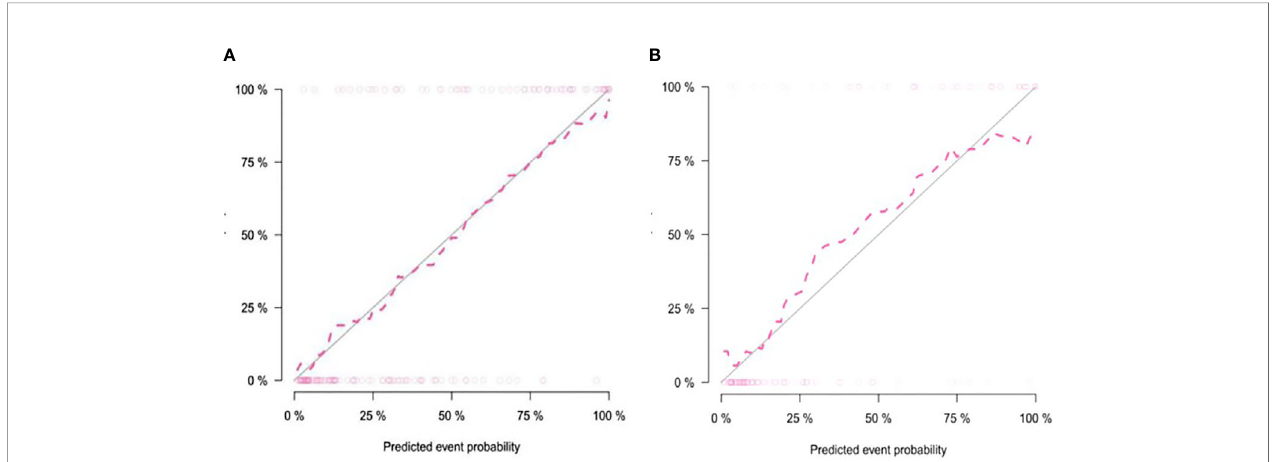
FIGURE 7 | Calibration curve of the nomogram in the training group (A) and validation group (B) . The solid diagonal line represents the perfect prediction of the ideal model, and the dashed pink line represents the performance of the model. Closer plots of the two lines indicate that the prediction results are in good agreement with the pathological results, and the prediction ability is